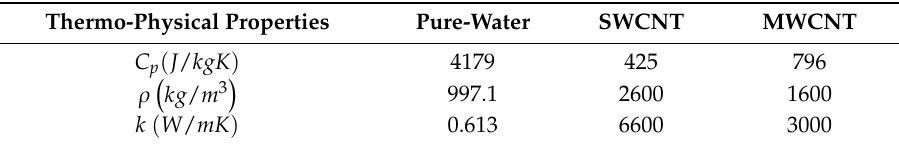
Table 1. Thermo-physical properties of the base fluid and nanoparticles.